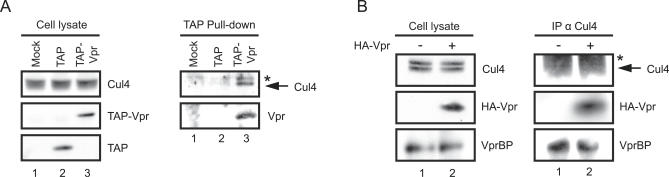
Vpr Associates with the Ubiquitin Ligase Scaffold Protein CUL4A(A) Five million HEK293T cells were transfected with 40 μg of empty (lanes 1), TAP-expressing (lanes 2), or TAP-Vpr–expressing plasmids (lanes 3). Forty-eight hours after transfection, TAP pull-downs were performed on cell lysates using IgG-coupled beads, and purified complexes were eluted by cleavage with TEV protease. The levels of endogenous CUL4A were monitored in crude lysates and pulled-down fractions by Western blot using a polyclonal goat anti-CUL4A antibody. TAP, TAP-Vpr, and cleaved Vpr were detected using a polyclonal rabbit antibody directed against a Vpr N-terminal peptide.(B) Ten million HEK293T cells were transfected with 80 μg of empty plasmid (lanes 1) or with HA-Vpr–expressing plasmid (lanes 2). Immunoprecipitation of endogenous CUL4A was performed using a goat polyclonal anti-CUL4A antibody and protein A–sepharose beads. The levels of endogenous CUL4A, VPRBP, and over-expressed HA-Vpr were monitored in crude lysates and immunoprecipitated fractions by Western blot using, respectively, a polyclonal goat anti-CUL4A antibody, a polyclonal rabbit anti-VPRBP antibody, and a monoclonal mouse anti-HA antibody.* represents a non-specific protein detected by the anti-CUL4A antibody. The anti-CUL4A antibody generally recognized a doublet of CUL4A when the gel resolution was sufficiently high. In the TAP pull-down fractions, only the upper band of CUL4A was detected.